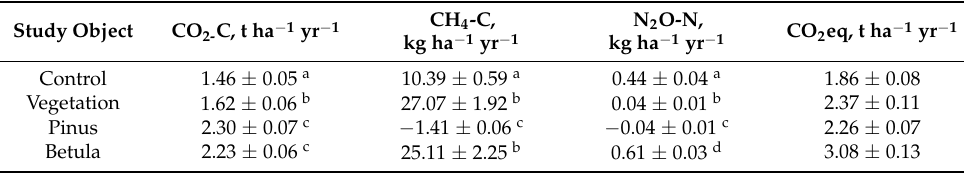
Table 4. The annual soil CO 2 -C, CH 4 -C, N 2 O-N flux and CO 2 eq in study